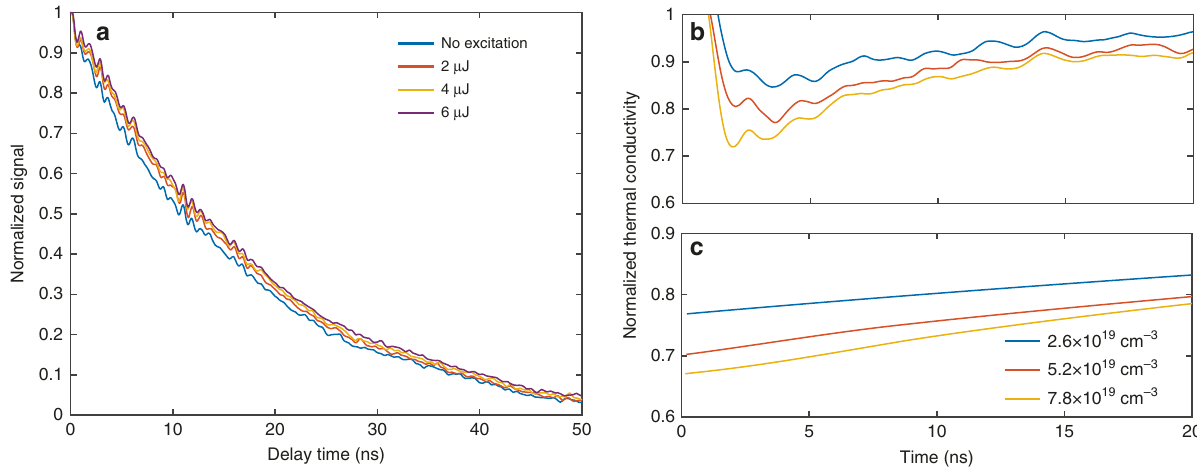
Fig. 2 Transient heat transport with photo-excited carriers. a Signals (after subtracting the background signals) under different excitation fl uences normalized to their values at the excitation time, which is taken as the time zero. At the highest excitation pulse energy of 6.0 μ J, the initially generated density of electron – hole pairs is 7.8 × 10 19 cm − 3 . The thermal decay becomes slower with higher carrier density due to the scattering of phonons by electrons and holes. b Normalized time-varying effective thermal conductivity extracted from experiments at three different carrier densities. c Normalized effective thermal conductivity obtained from model. The thermal conductivities in b and c have been normalized to the value without excitation. The general agreement between b and c indicates that the transient heat transport is governed by the carrier dynamics as phonon scattering by free carriers limits the thermal Fig. 1c (red curve) in comparison with the result without exci- tation (blue curve). The background signals (obtained with same excitation and probe con fi guration and without pump) are sub- tracted to ensure zero baseline. Differences in the signals are clearly seen following the photoexcitation of electron – hole pairs.